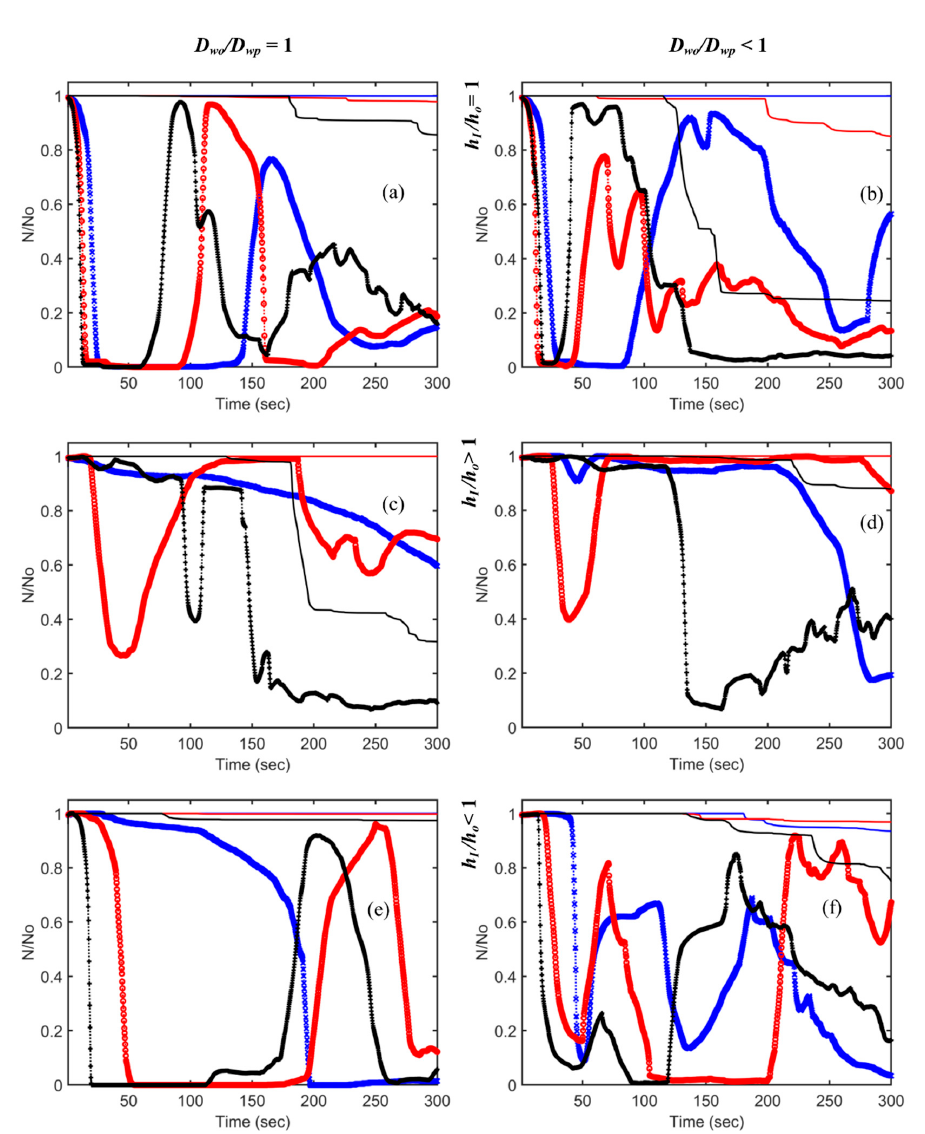
Figure 6. Temporal change of particle number in the domain and in the breathing zone (solid lines—whole domain; lines with markers—breathing zone; blue, red, and black represent ACH = 3, 5, and 7, respectively): ( a ) cases 1, 2, and 3; ( b ) cases 4, 5, and 6; ( c ) cases 7, 8, and 9; ( d ) cases 10, 11, and 12; ( e ) cases 13, 14, and 15; ( f ) cases 16, 17, and 18.